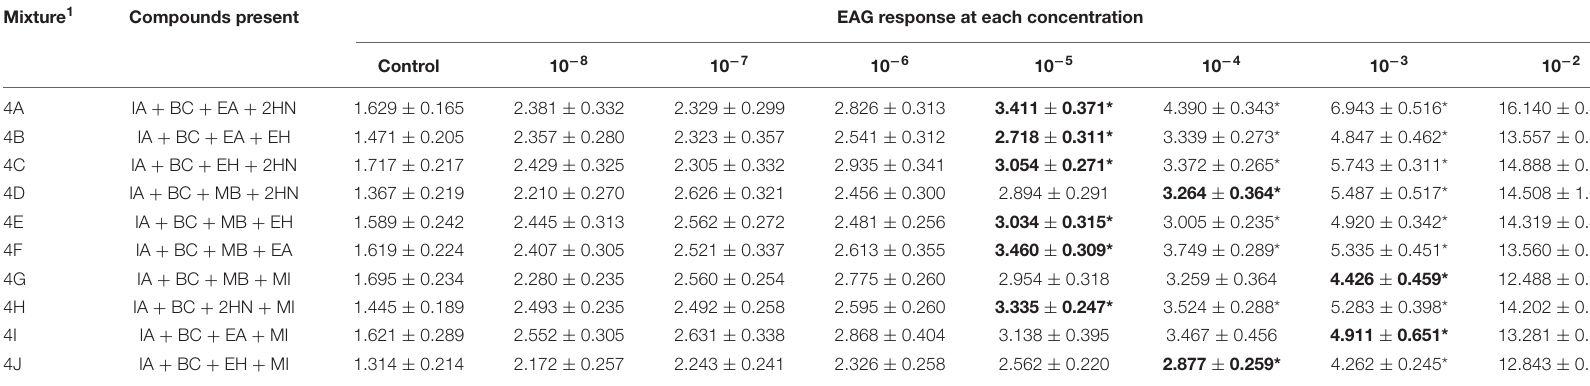
TABLE 3 | Electroantennogram (EAG) responses (mean ± SEM) of female D. suzukii to different concentrations of mixtures with 4 compounds. Mixture 1